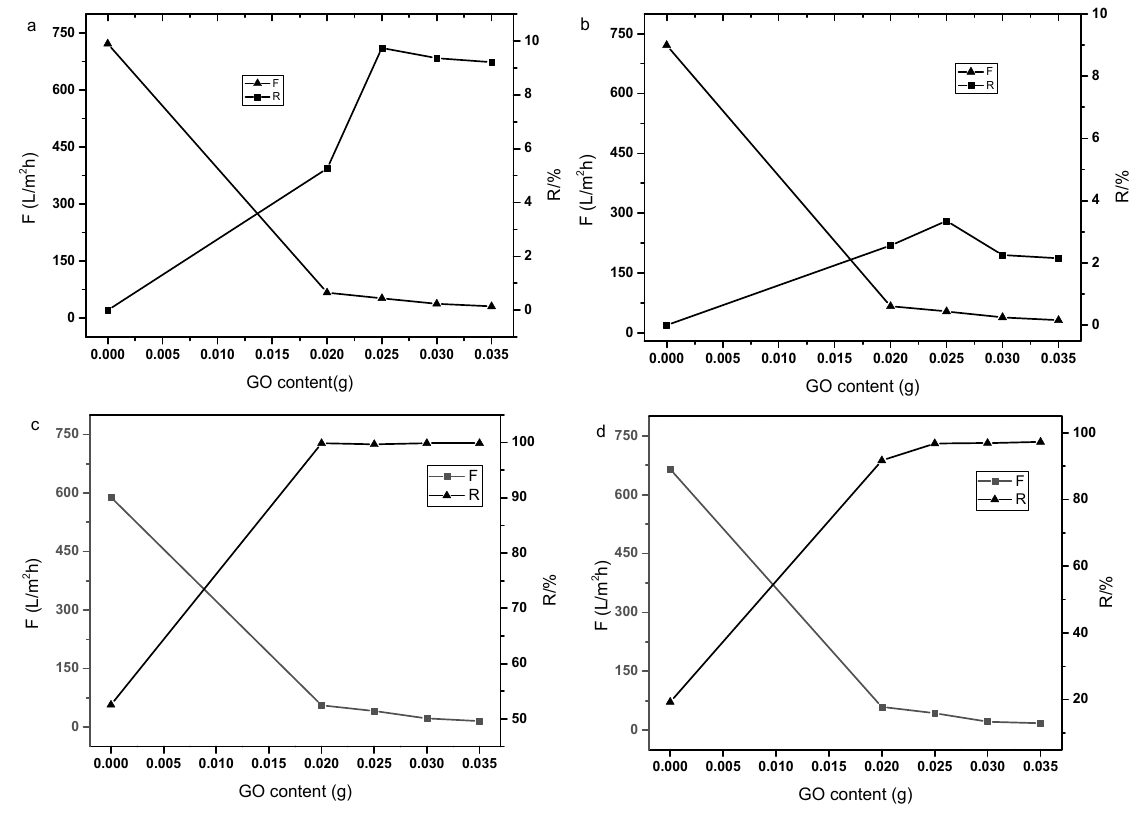
Figure 1. Effect of GO content in the solution on the performance of composite membrane (( a ): Na 2 SO 4 , 1 g · L − 1 ; ( b ): MgCl 2 , 1 g · L − 1 ; ( c ): Congo red, 50 mg · L − 1 ; ( d ): Methyl orange, 50 mg · L − 1